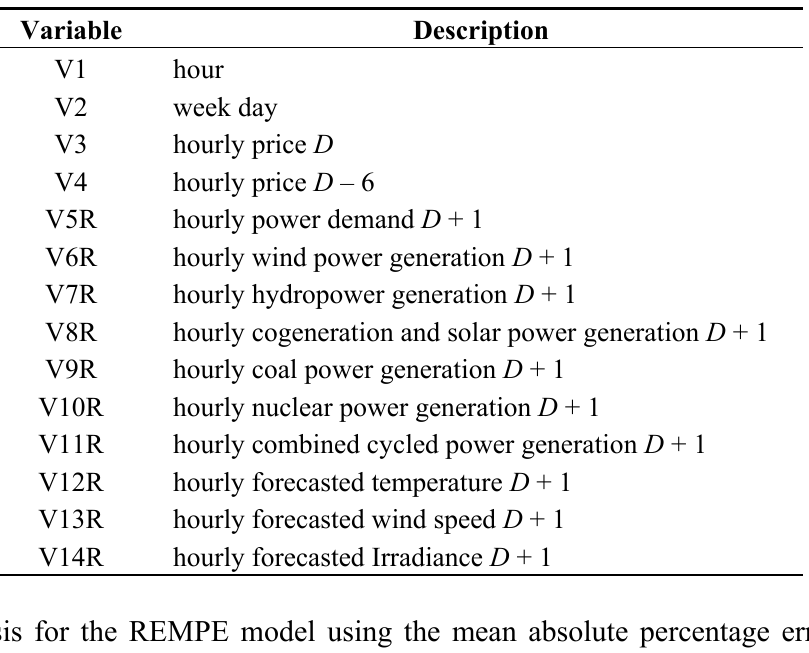
Table 1. Explanatory variables of the reference explanatory model for price estimations (REMPE)